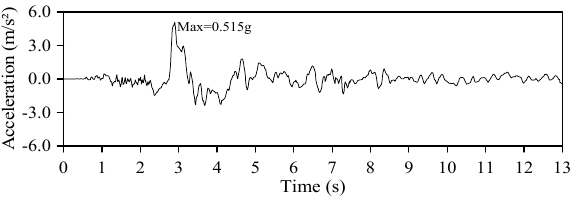
Fig. 5. The time-history of ground motion acceleration of the 1992 Erzincan Earthquake.